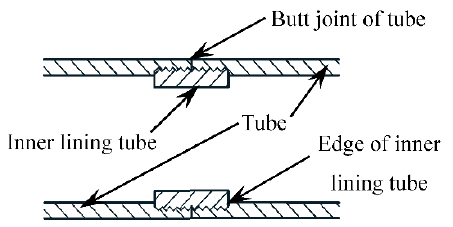
Figure 2. Schematic diagram of steel tube lengthened by thread through inner lining tube.